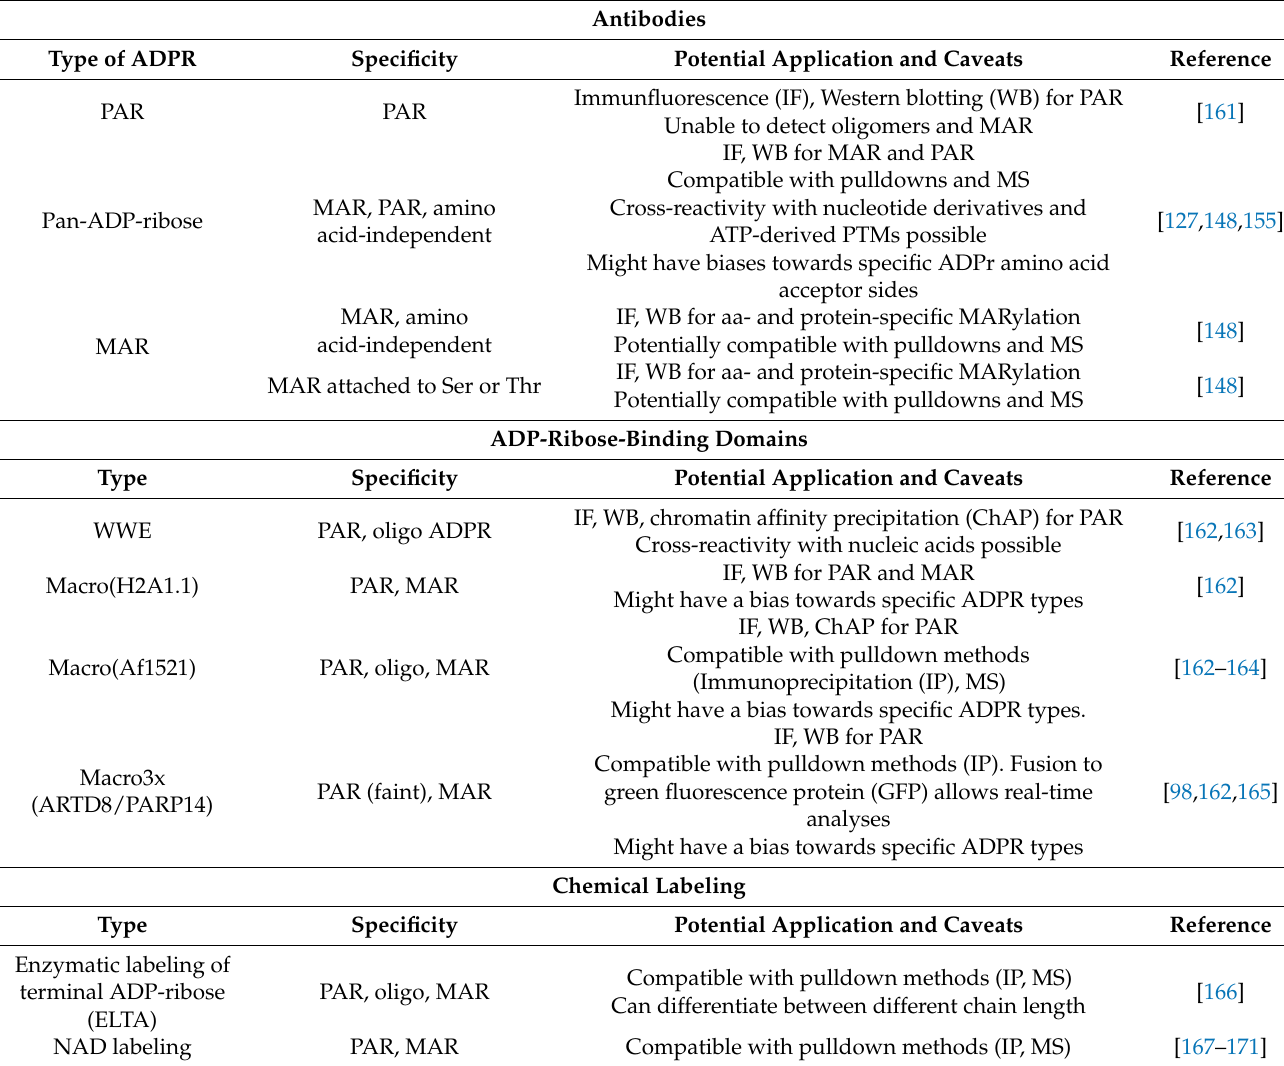
Table 2. Overview of currently available ADP-ribosylation detection